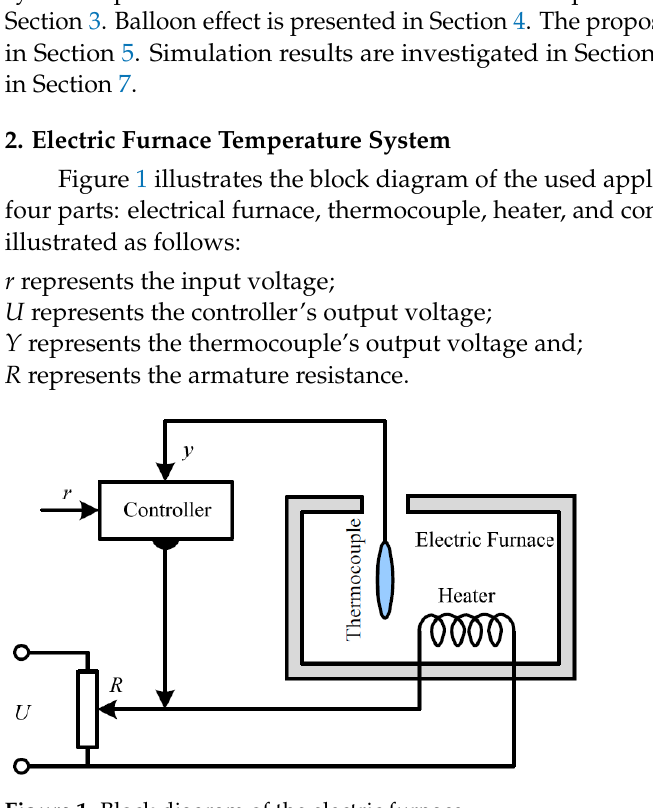
Figure 1. Block diagram of the electric furnace.